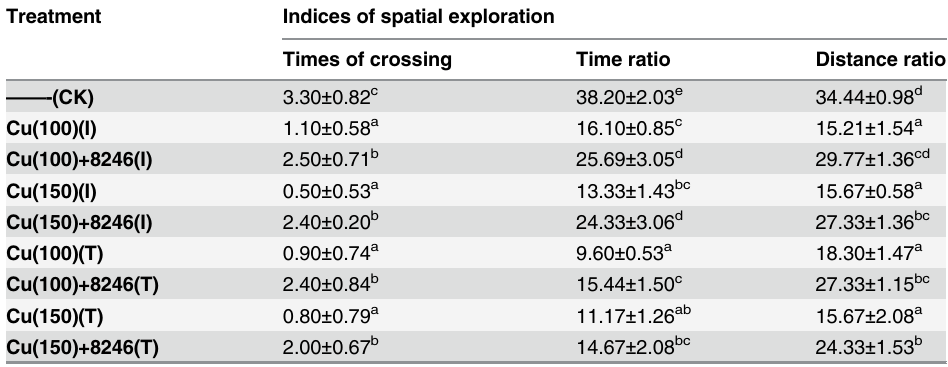
Table 5. The results of Morris water maze experiment (spatial exploration experiments).